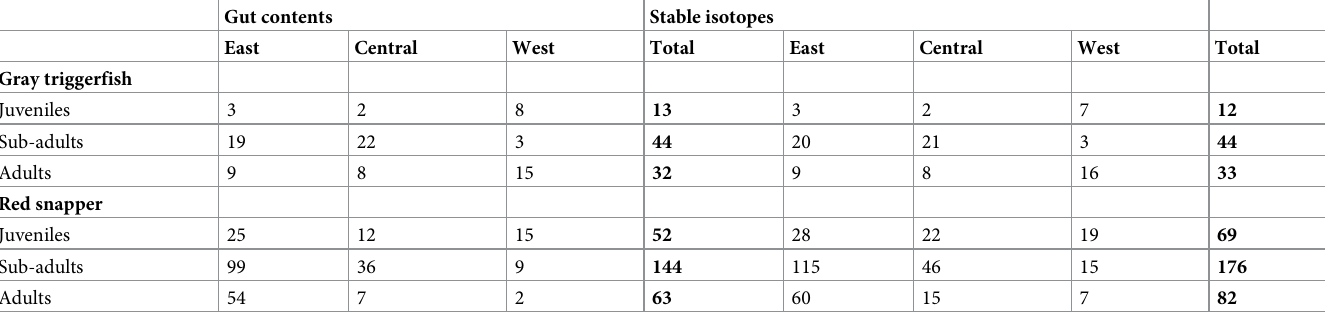
Table 1. Gray triggerfish and red snapper sample sizes for gut content and stable isotope